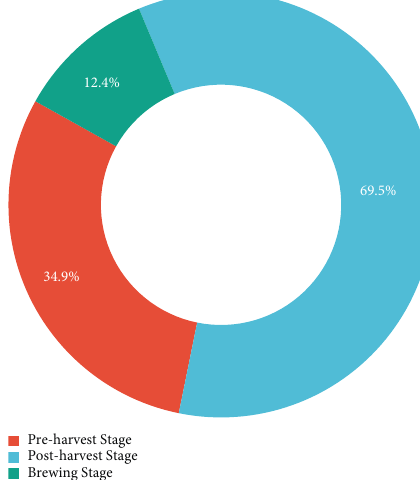
Figure 8: Percentage of the articles classified by the stage of the production